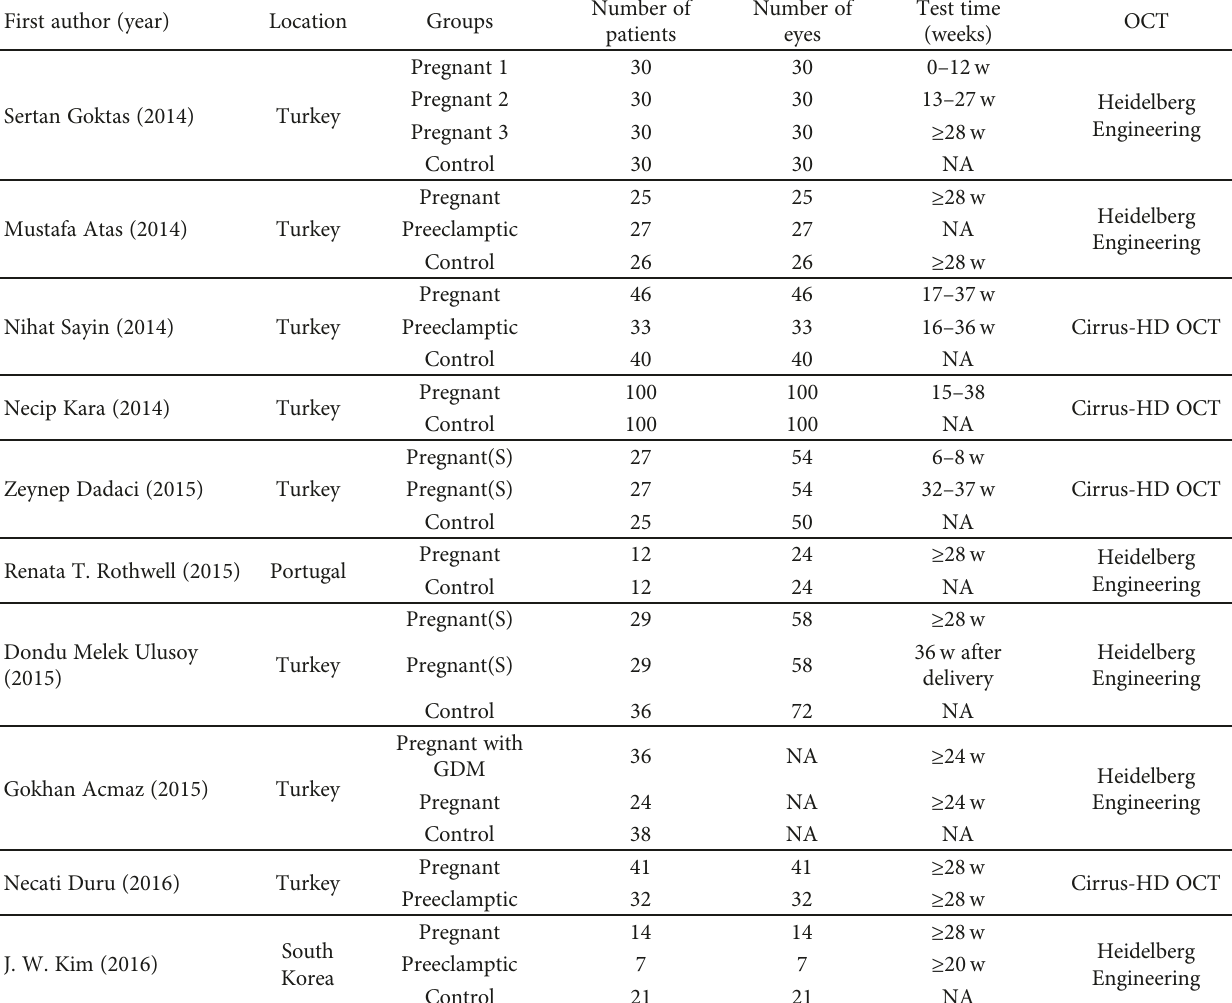
Table 1: Characteristics of included studies that discovered the association between choroidal thickness and